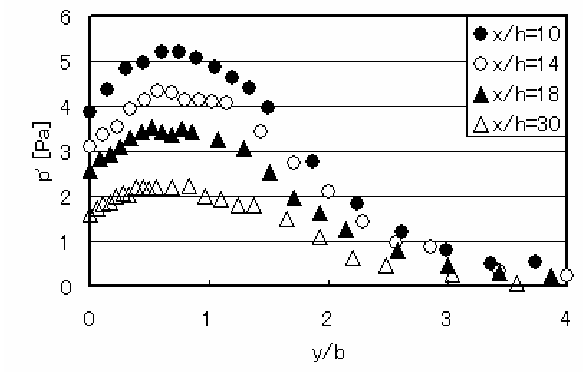
Fig. 15 Fluctuation pressure distributions ( Re =3.0×10 4 ).